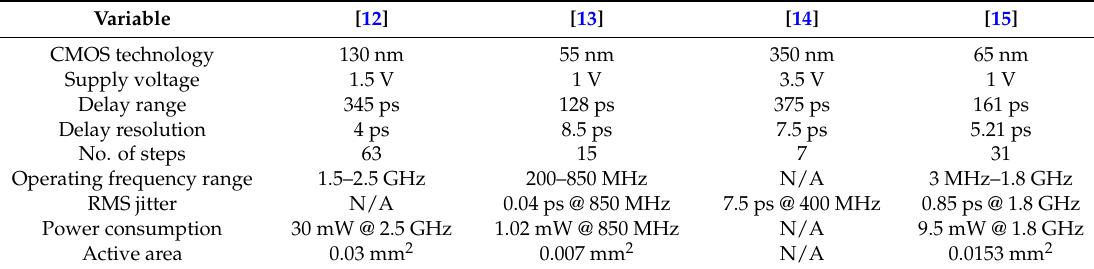
Table 1. Performance specifications of previously reported high-resolution